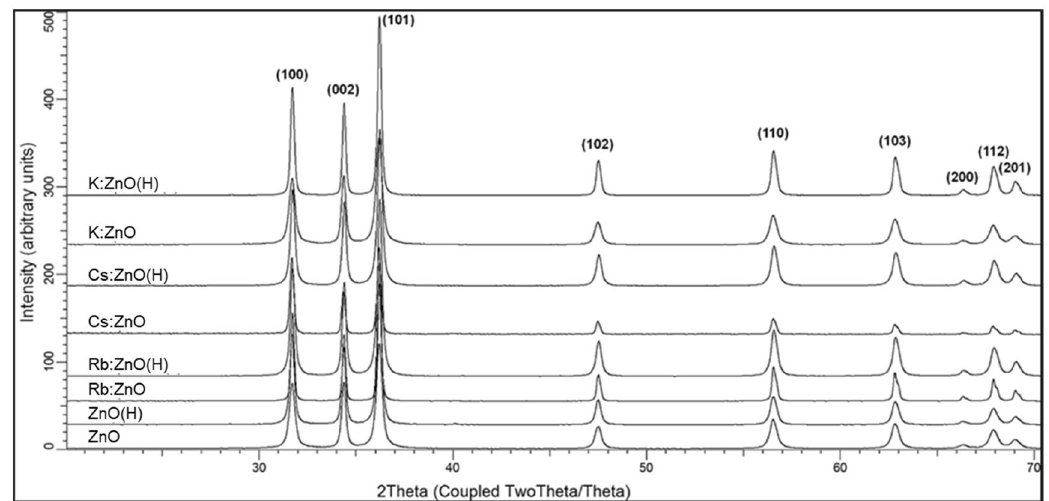
Figure 3. XRD pattern of undoped, doped powders, as-prepared and heat treated ZnO samples.